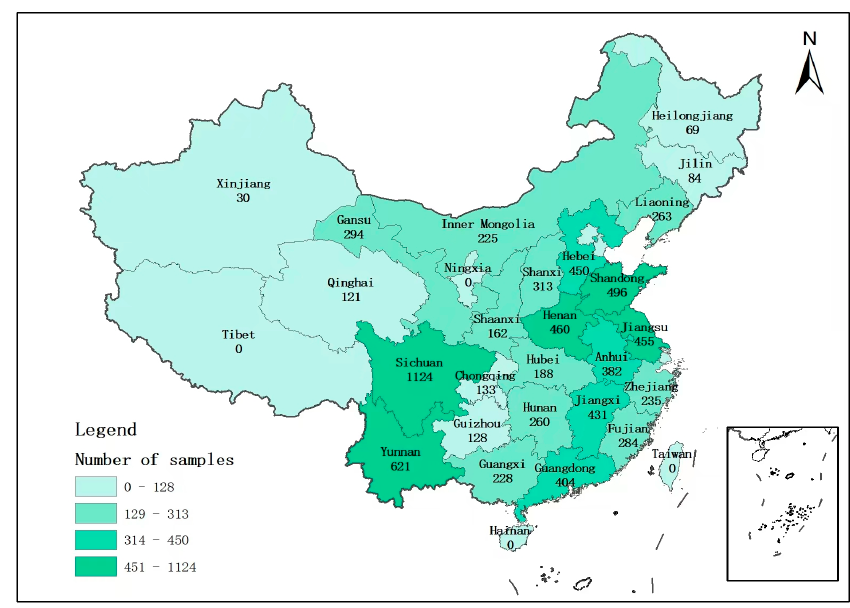
Figure 2. Distribution of sample data by province in